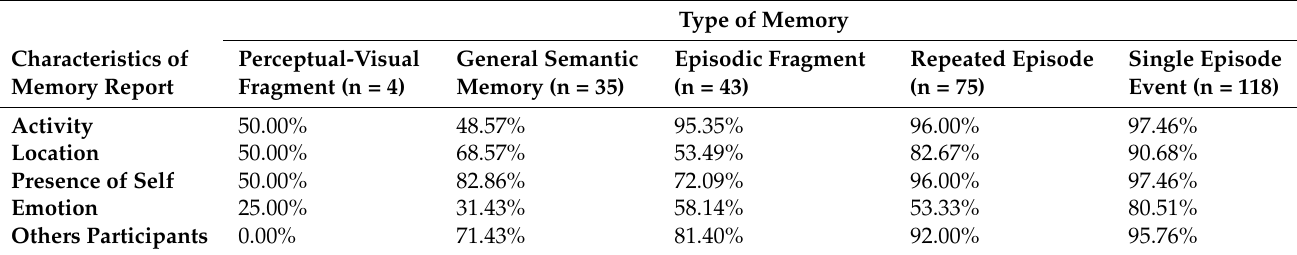
Table 3. Frequencies of the details reported according to the different types of memories when present (the total number of memories was 275).